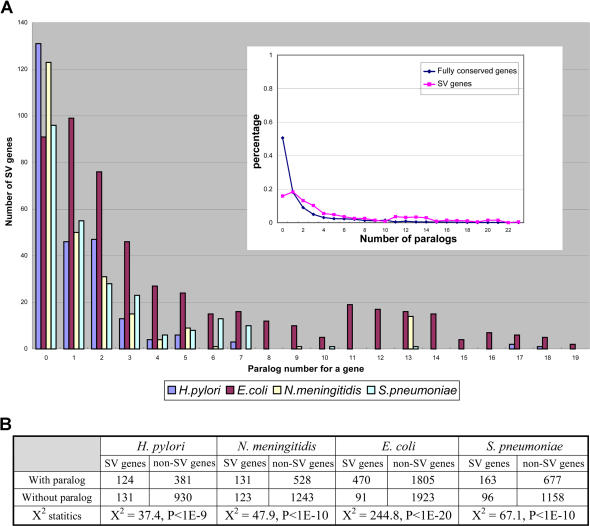
Paralogous Genes in SVGs(A) Paralog families in SVGs for four microorganisms. The x-axis shows the number of paralogs for each SVG. The y-axis shows the number of SVGs. The inset figure shows the percentage of genes with different numbers of paralogs for SVGs and fully conserved genes in E. coli genome. The x-axis is the number of paralogs, and the y-axis is the percentage.(B) Contingency tables to examine the dependence between SVG and paralogous gene. χ2 statistics are computed using standard formula.